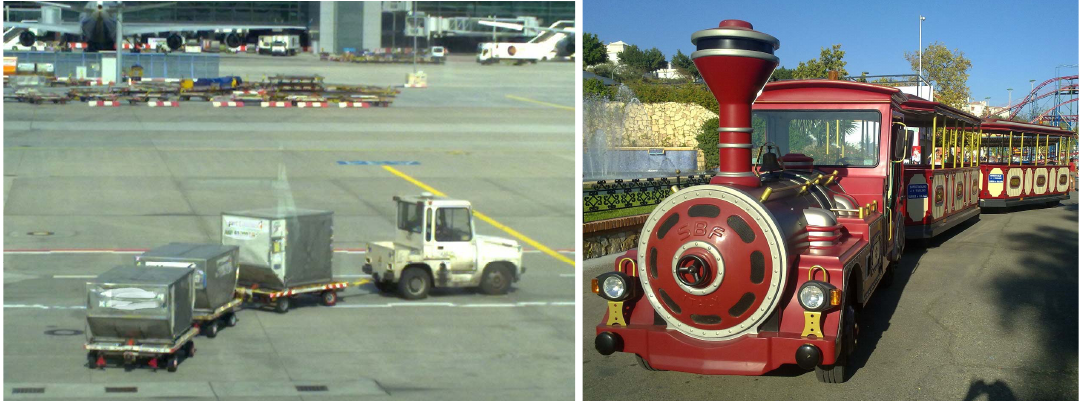
Figure 1. Examples of multi-trailer systems: Baggage carriers in an airport ( left ) and a tourist road train ( right